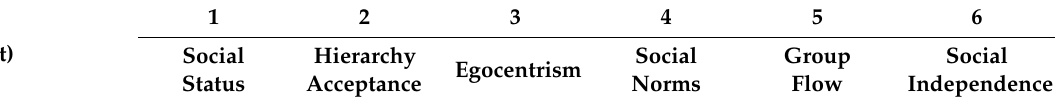
Table 2. Loadings of items to factors of the Latency Social-Psychological Developmental Question- naire (LSPD)